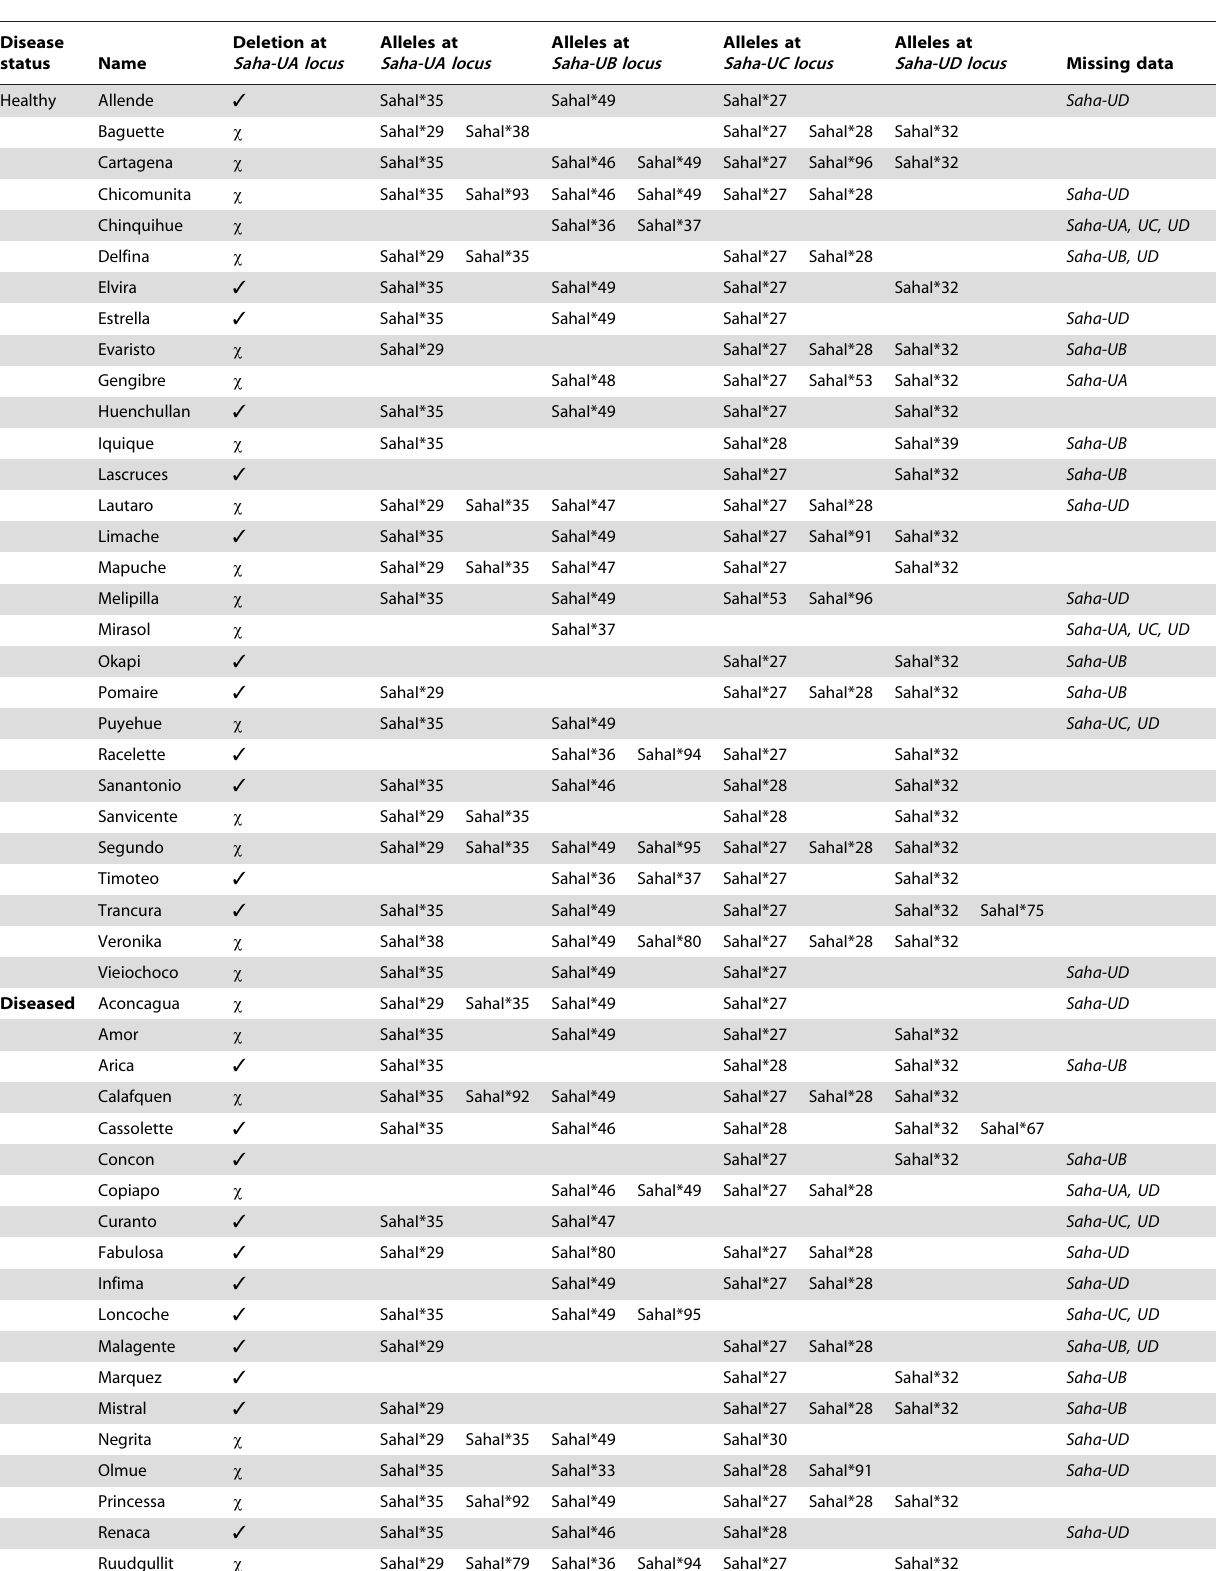
Table 1. Tasmanian devils sequenced using the MHC class I primers developed by Siddle et al [41] and screened for a deletion at the Saha-UA locus in this same gene